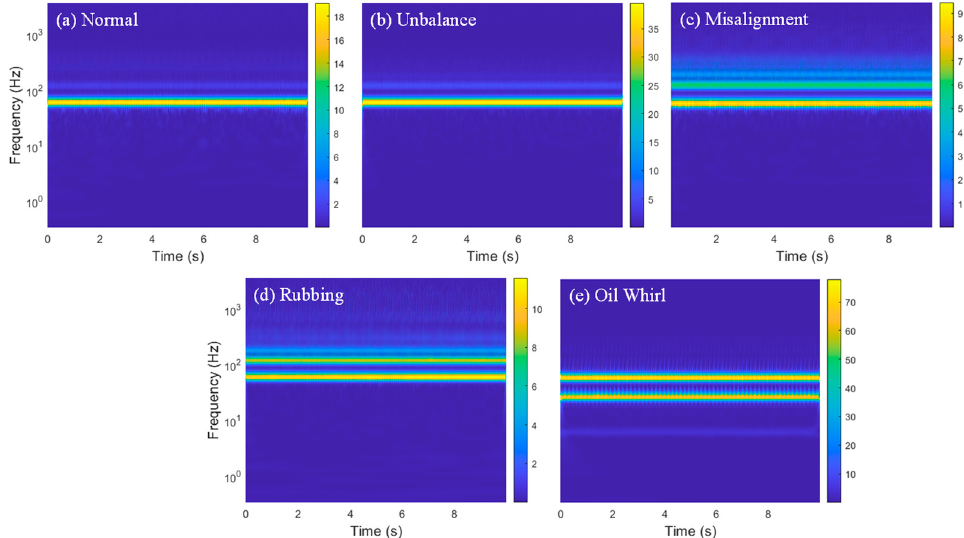
Figure 10. Sample scalograms of different health states in the RK4 Rotor kit at steady state of 3600 rpm: ( a ) normal; ( b ) unbalance; ( c ) misalignment; ( d ) rubbing; and ( e ) oil whirl ( y -axis is a logarithmic scale).